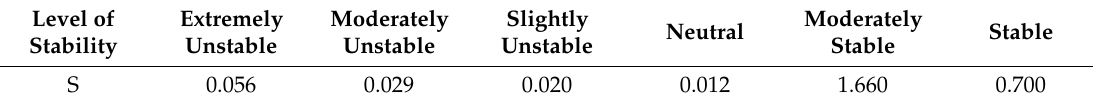
Table 1. Mixed layer parameter reference